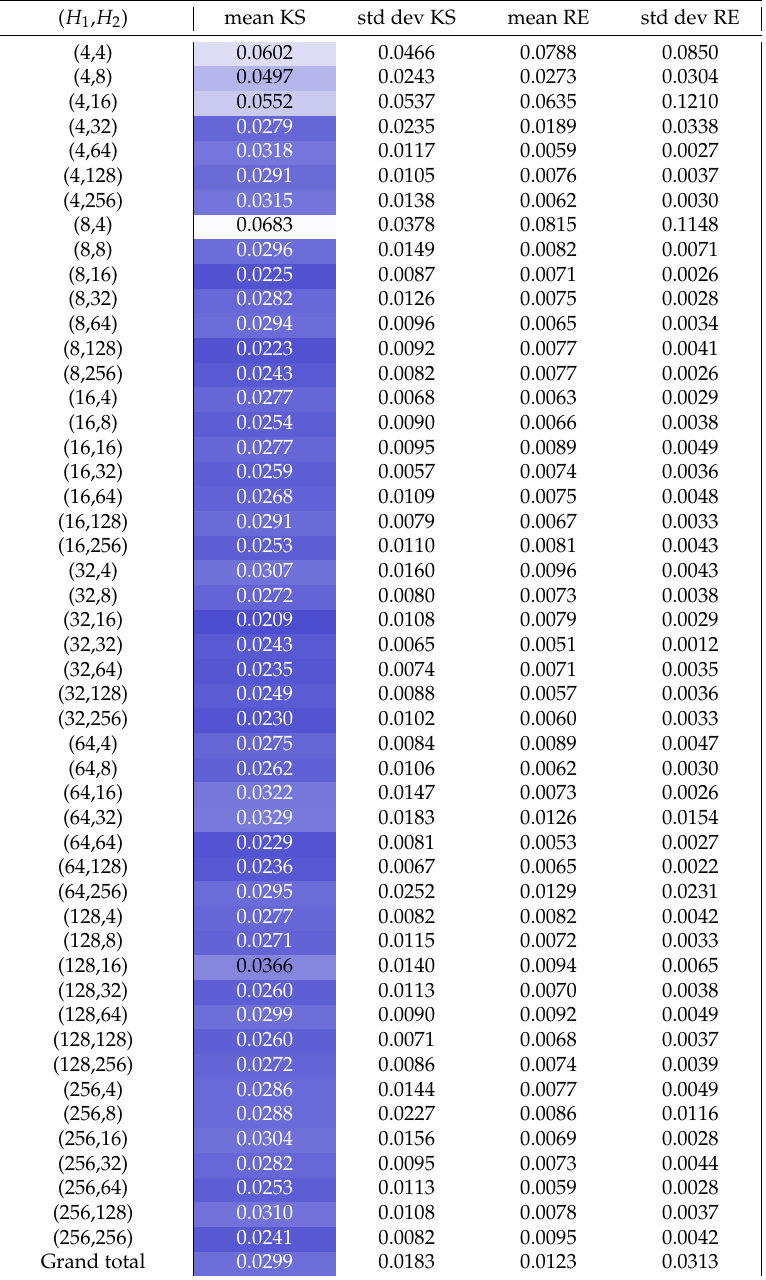
Figure A3. The values of the Kolmogorov-Smirinov statistic and the relative entropy, at the end of the training, from test set B. For both metrics, the lower the better. Notice that we included in the sample also non-convergent runs.